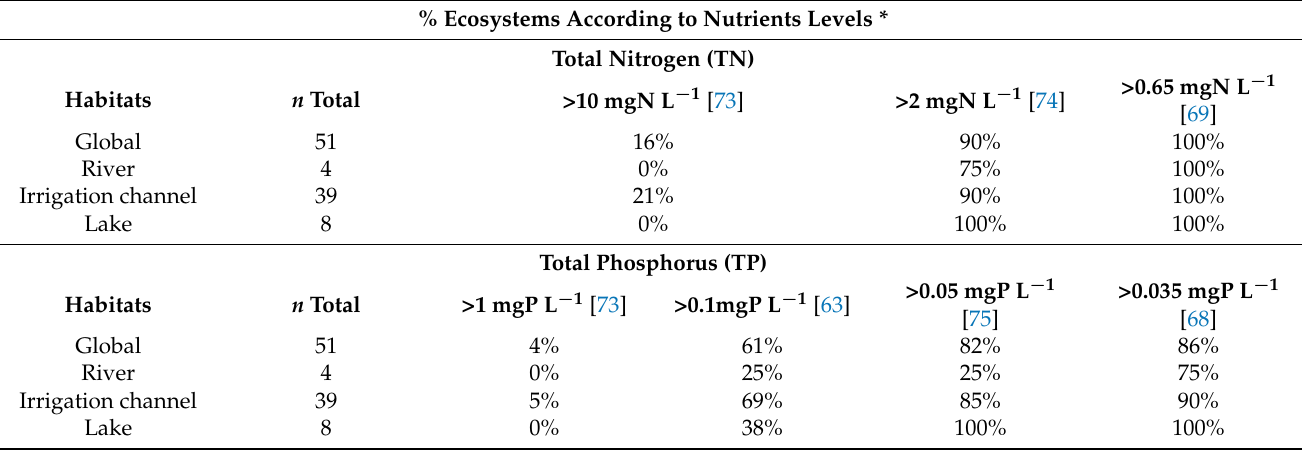
Table 3. Percentages of TN and TP for the different studied aquatic systems respect to the limits referenced. % Ecosystems According to Nutrients Levels